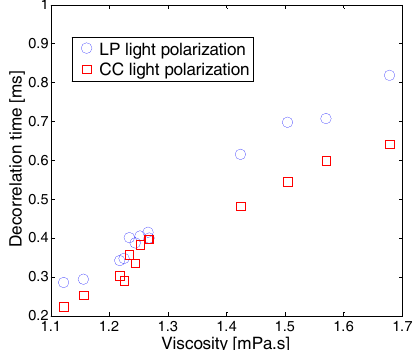
Figure 5. Variation of the speckle decorrelation time τ c as a function of white wine viscosity. Symbols correspond to experimental values and lines correspond to linear fits. Standard deviations are approximately ± 0.001 mPa.s for the viscosity, and ± 0.006 ms for the decorrelation time τ . Error bars are not displayed on the figures for the sake of clarity.